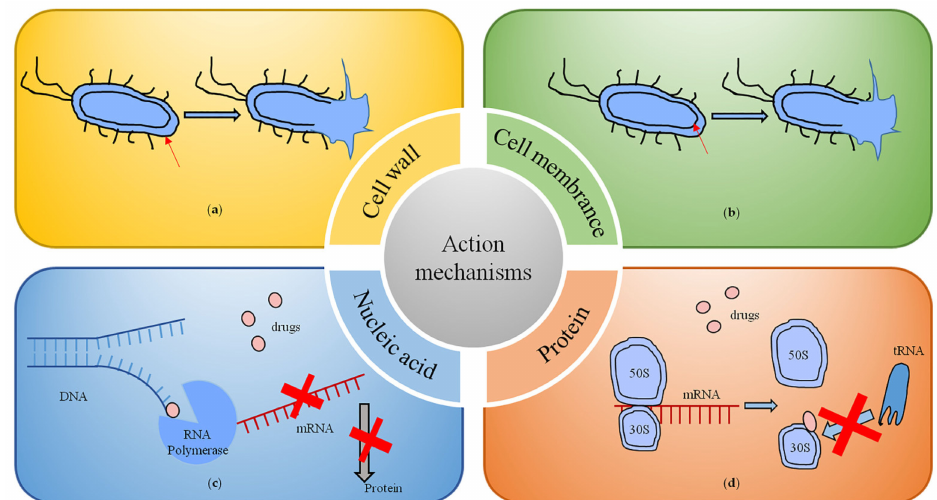
Figure 2. Mechanisms of antibiotic action. ( a ) Inhibition of bacterial cell wall synthesis. ( b ) The targets and interactions with bacterial cell membranes. ( c ) Inhibition of nucleic acid synthesis. ( d ) Inhibition of protein